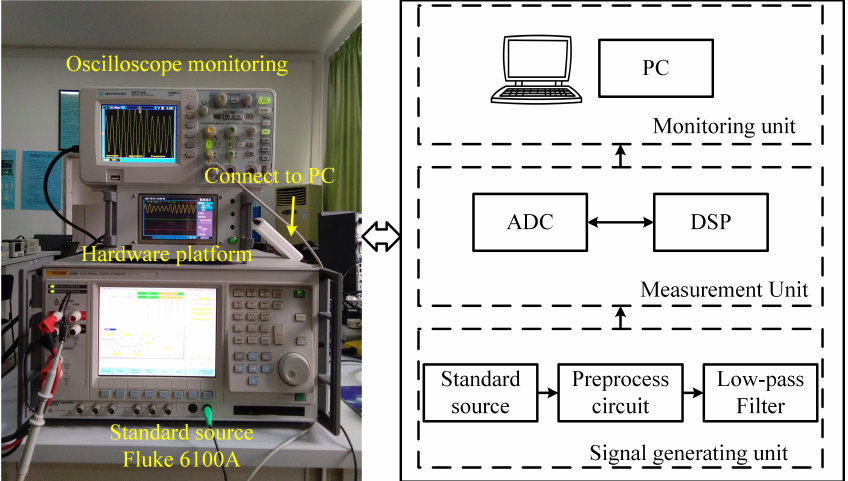
Figure 11. Hardware experiment platform and structure diagram for real-time PQD signals diagnosis.